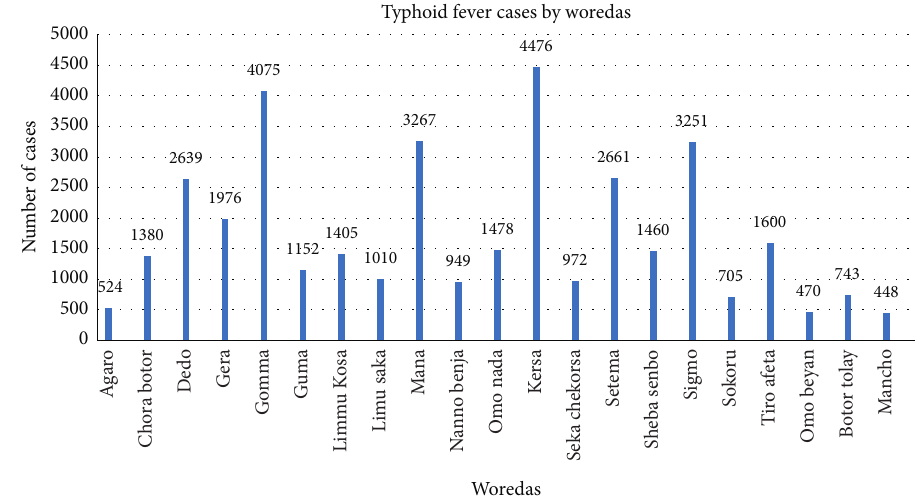
Figure 5: Typhoid fever cases by woredas in the Jimma Zone, Oromia Region, Southwest Ethiopia, from 2015 to 2019.